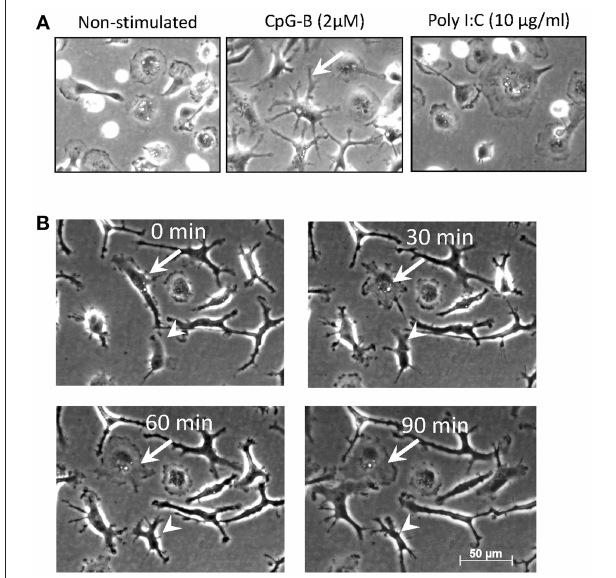
FIGURE 1 | Salmon MPs develop dendritic morphology following prolonged treatment with CpGs. (A) Images of non-stimulated MPs and cells stimulated for 7 days with 2 µ M CpGs and 20 µ g/ml of polyI:C. The arrow indicates a typical DC-like cell observed in the CpG-treated samples. (B) Dynamic reorganization of the morphology of CpG-treated MPs. Cells were stimulated as in panel A and images were taken at 30min intervals over a period of 90min. The arrow points at elongated DC-like cell which changes morphology into a more rounded macrophage-like cell. The arrowhead indicates a cell which undergoes the opposite changes. Images were taken at X200